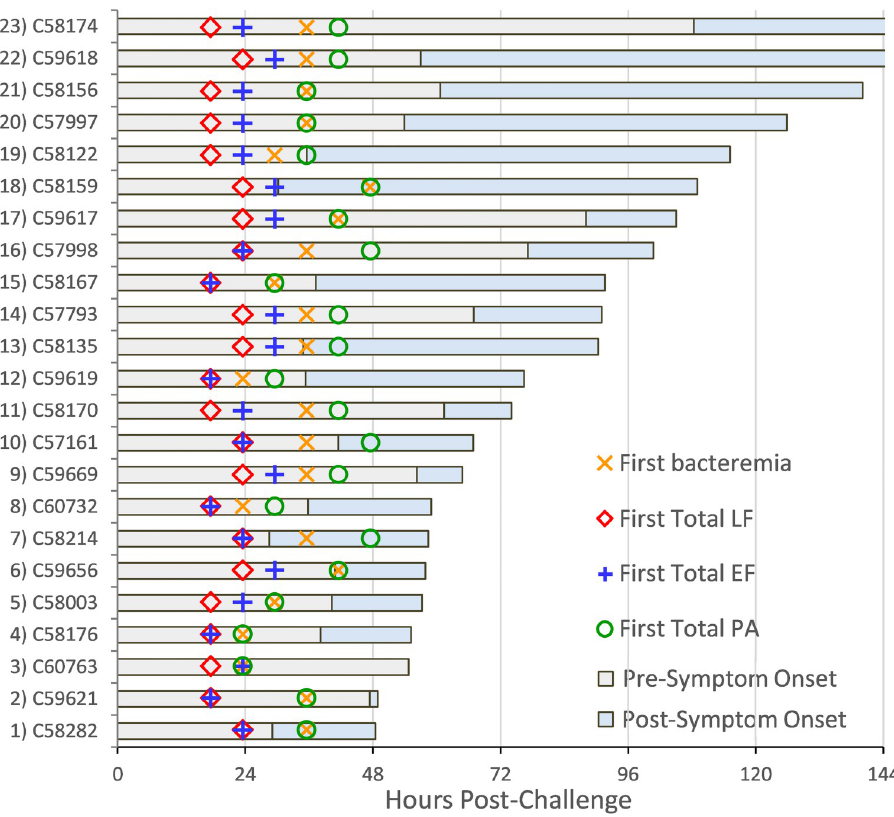
Fig 1. First detection of anthrax biomarkers. First detection of biomarkers relative to symptom onset in 23 cynomolgus macaques with inhalation anthrax. Pre-symptom onset period (gray bar) and post-symptom onset period (blue bar) out to 144 hours, for total lethal factor (LF), total edema factor (EF), total protective antigen (PA), and confirmed bacteremia. Detection limits for LF (0.0027 ng/mL), EF (0.00002 ng/mL), PA (1.87 ng/mL) and confirmed bacteremia ( � 100 cfu/mL). Non-confirmed results of ‘+’ excluded here but included in Table 2.